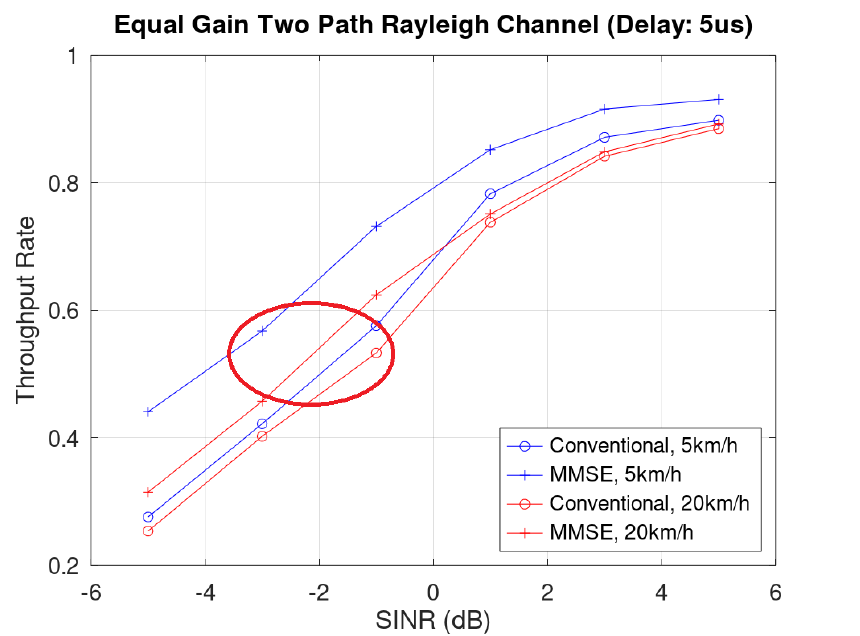
Figure 8. Throughput rate in an equal-gain two-paths Rayleigh fading channel with 5 us